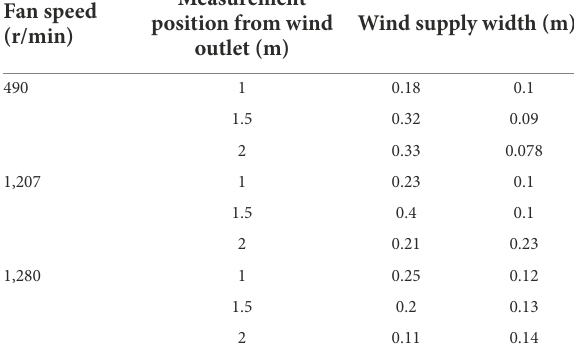
TABLE 1 The measurement range of the air delivery width of the